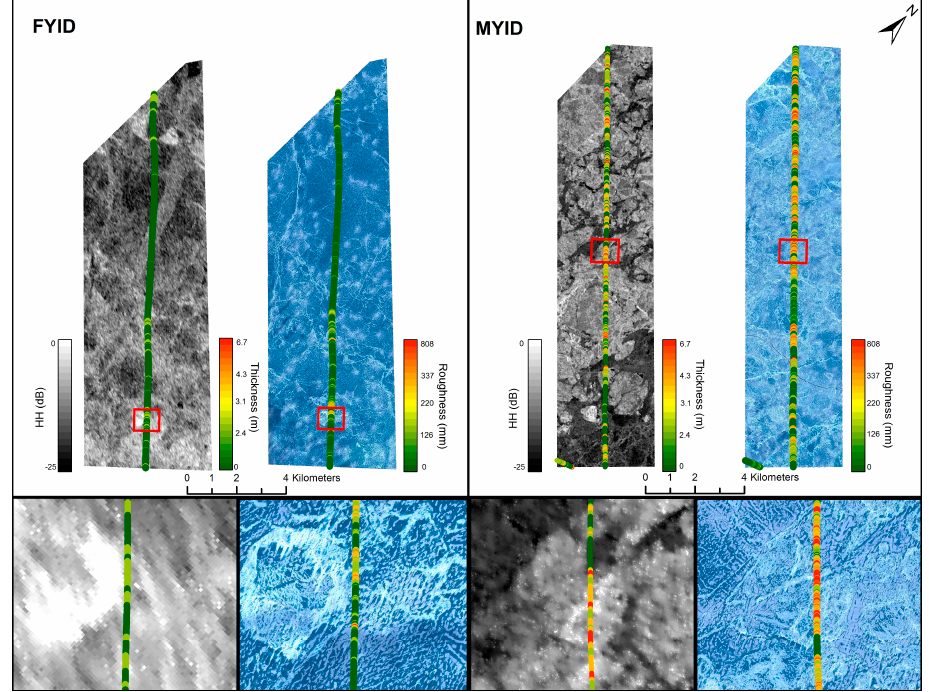
Figure 3. FYID ( left ) and MYID ( right ) ice zones. The first image in each panel is a winter RS-2 SAR image of the overlain by winter snow plus sea ice thickness measurements. The second image depicts the co-located spring GeoEye-1 optical scene of melt pond covered sea ice overlain by surface roughness measurements. Bottom panels show zoomed in data within the extents of the red polygons directly above each panel.